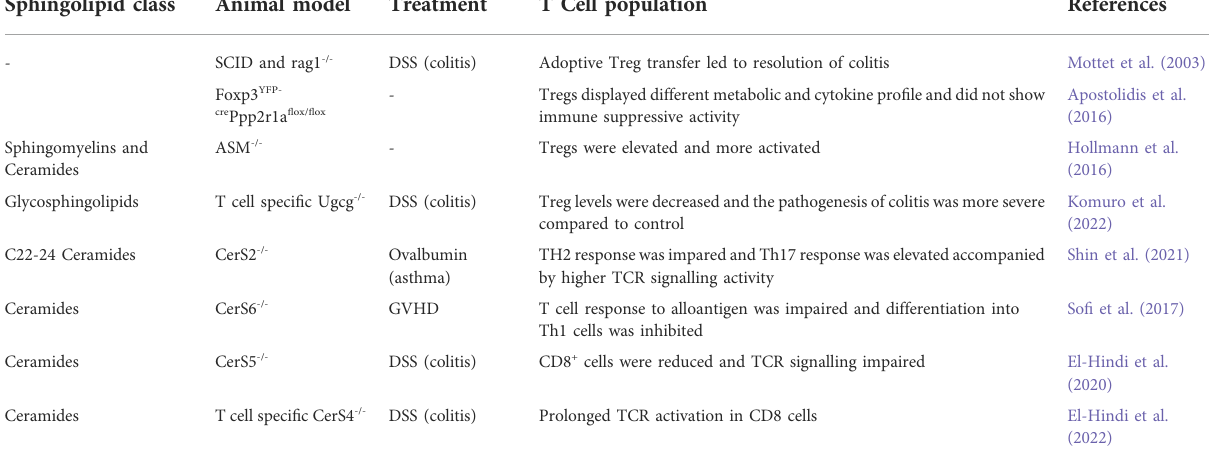
TABLE 1 Animal studies, showing the importance of sphingolipids in T